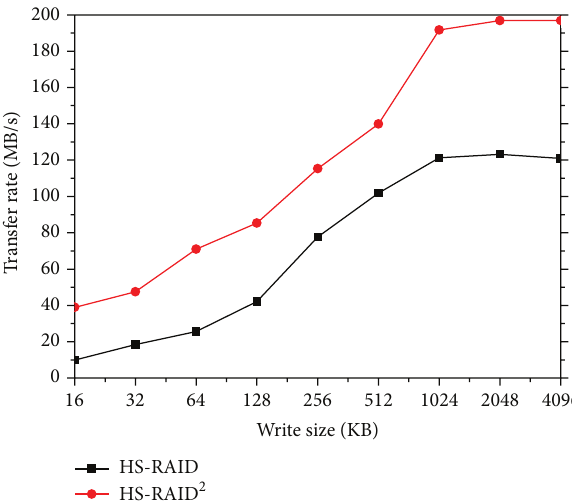
Figure 6: Performance of HS-RAID and HS-RAID 2 (1 disk per group).